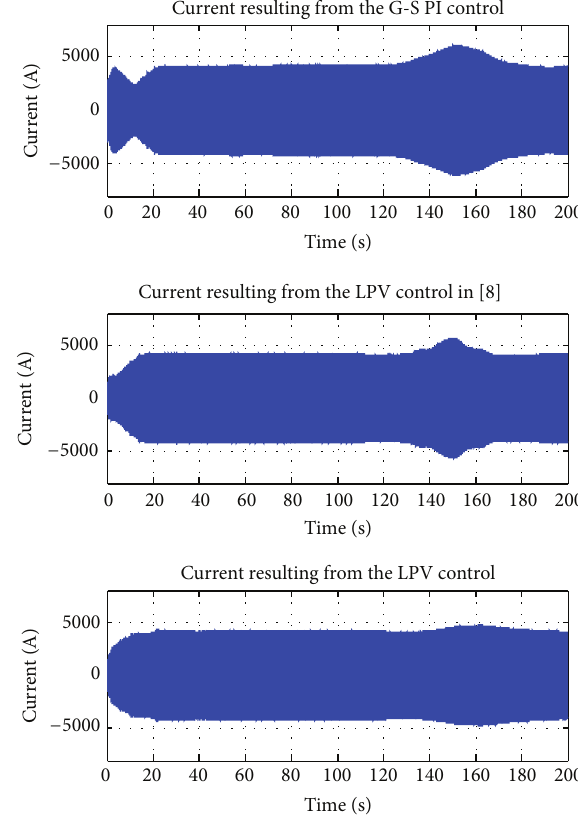
Figure 13: Simulation results of outputs.